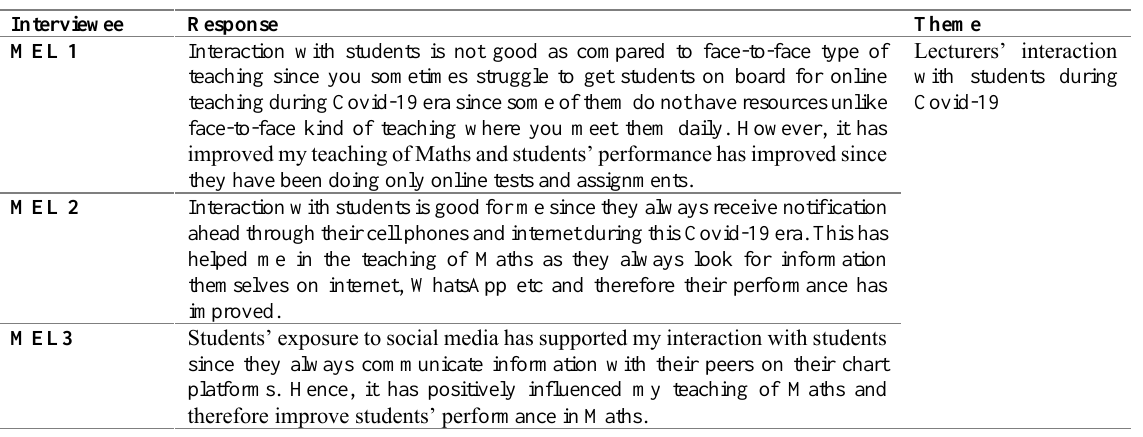
Table 6: Question 6 - How would you describe your interaction with your students during Covid-19 and how did it influence your